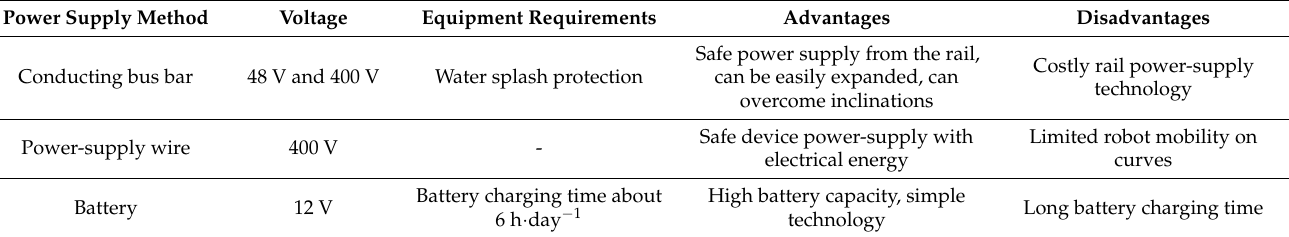
Table 1. Characteristics of different drive variants for rail-sliding